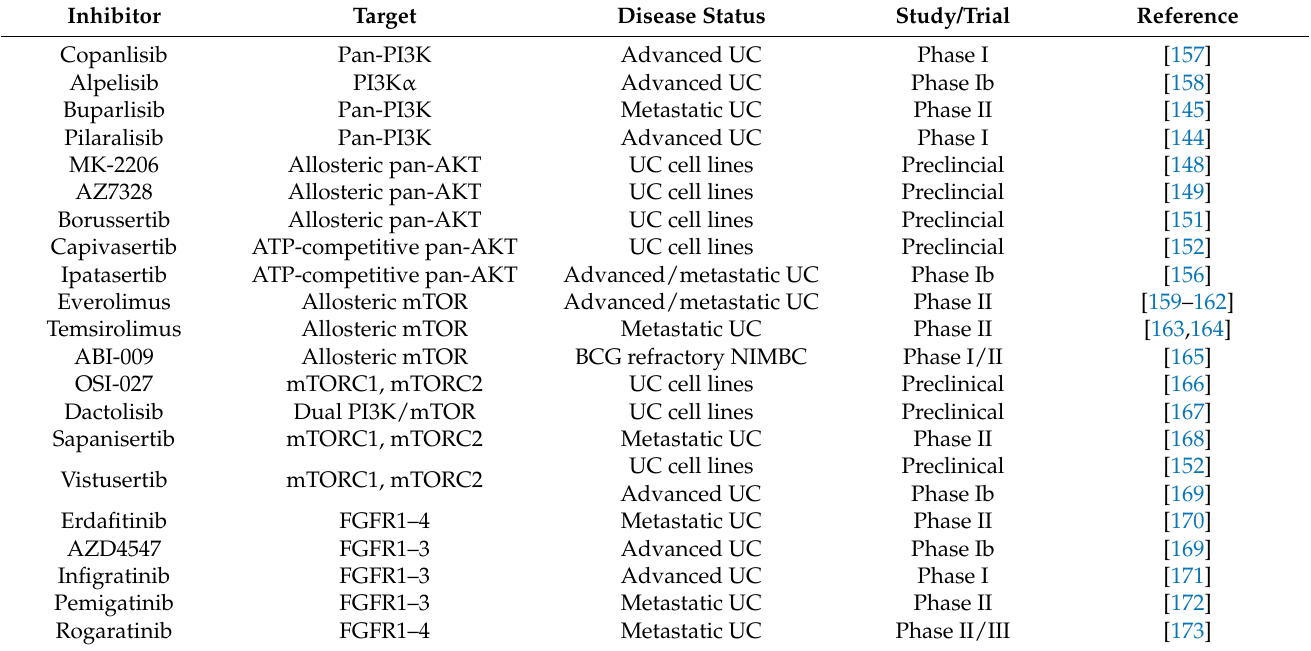
Table 1. Selected inhibitors evaluated in the preclinical studies and clinical trials related to